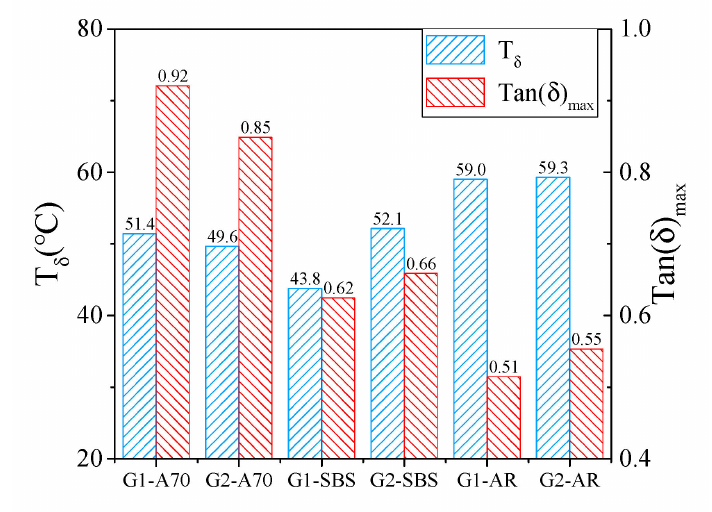
Figure 11. Maximum tan( δ ) and corresponding temperature T δ